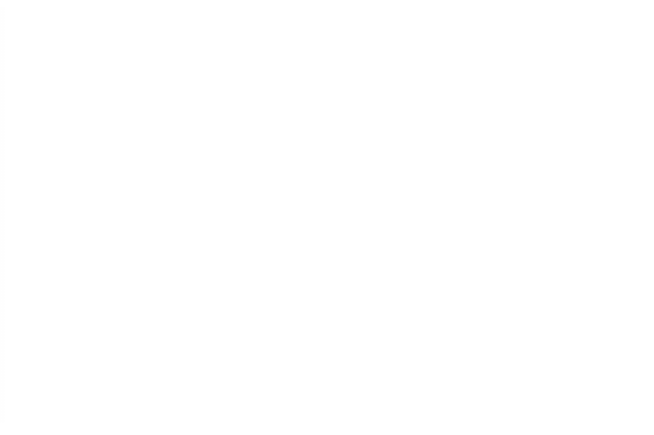
Figure 13. Band alignments respect to the O 2 and H 2 standard